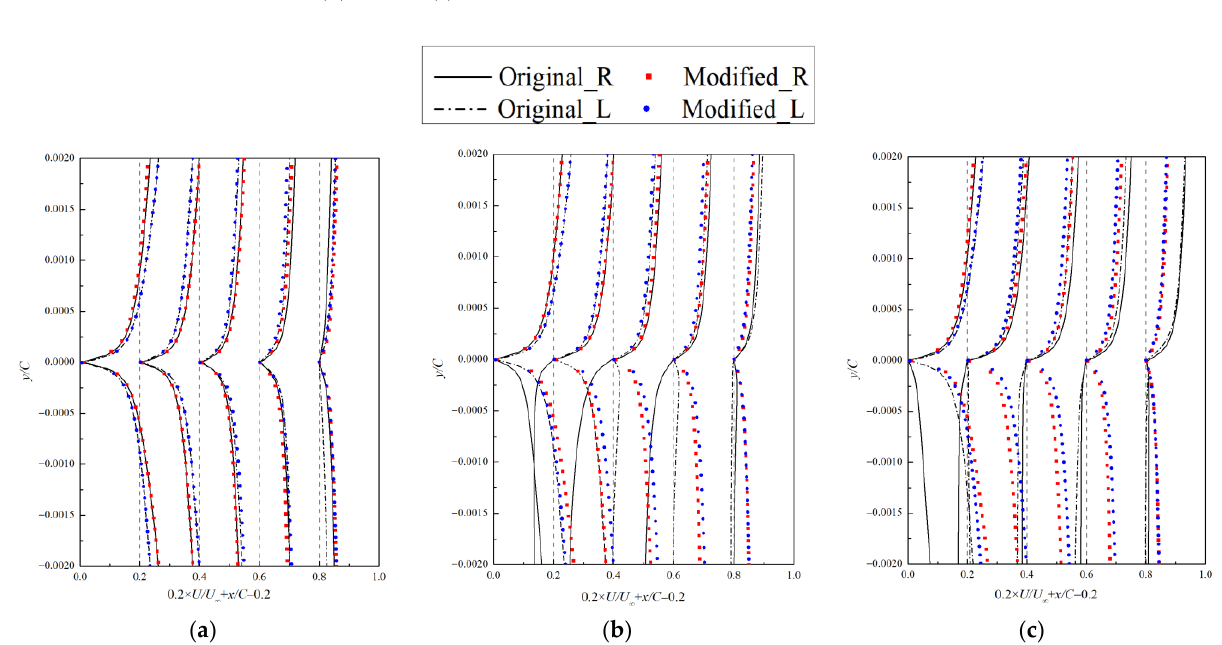
Figure 22. C p distributions on the left vertical tail part of the original and modified models: β = ( a ) 0°, ( b ) 2°, and ( c ) 4°.